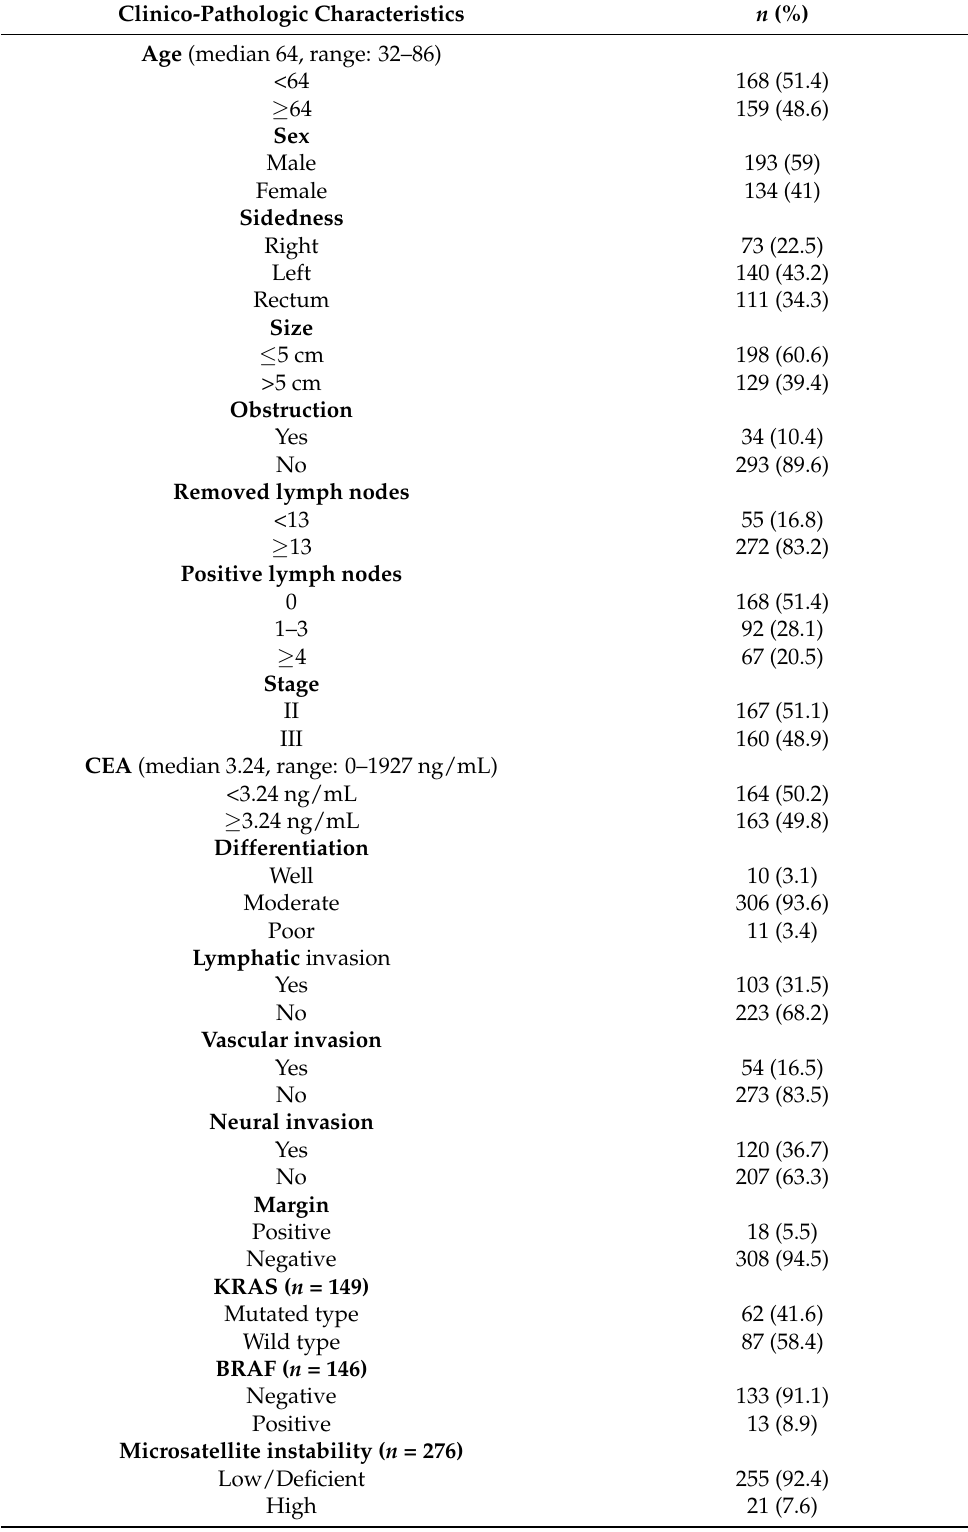
Table 1. Baseline characteristics and treatment ( n =